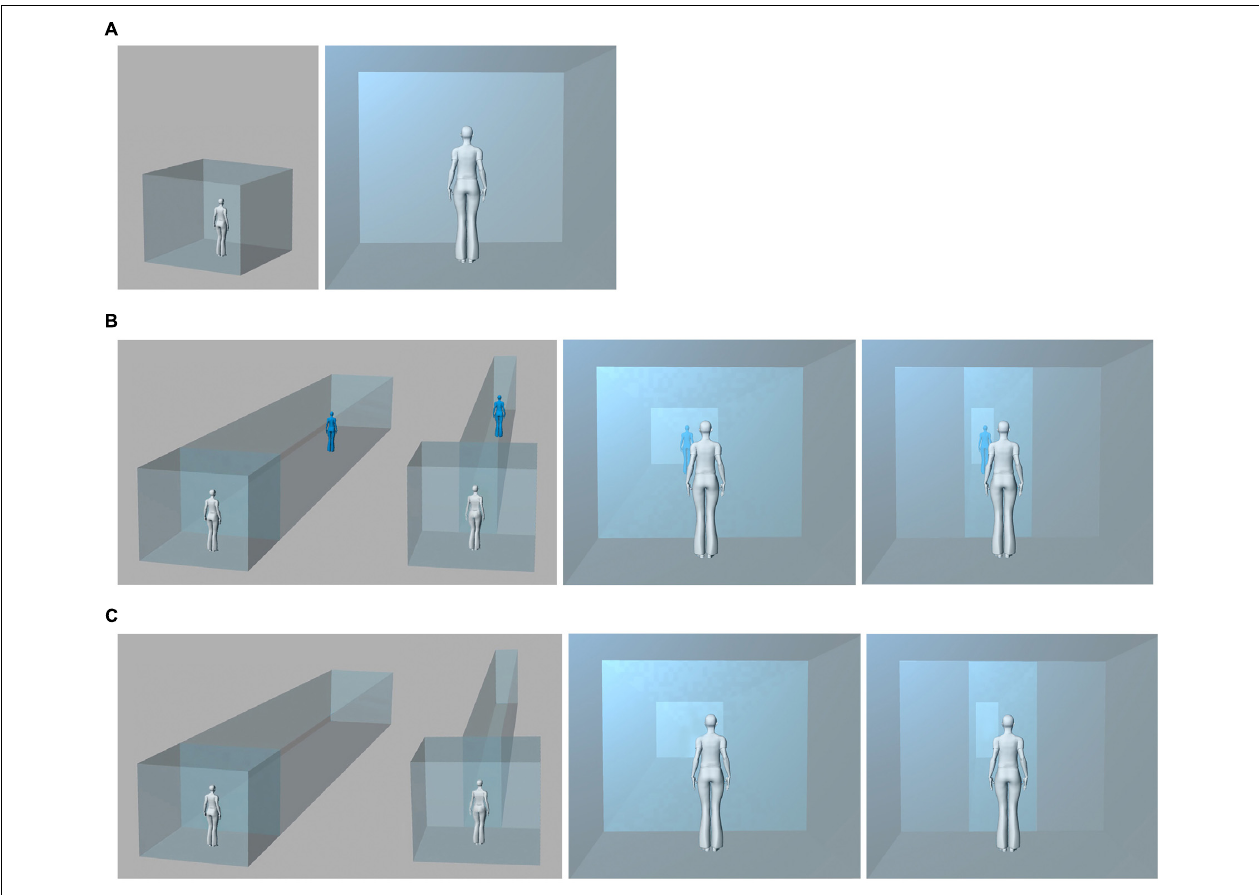
FIGURE 3 | The experimental setup. (A) The physical interior of the Virtual Reality arena: A Participant standing inside the Virtual Reality arena without virtual extension; her view in first person from behind the physical body oriented toward the rear-projection screen. (B) The physical interior and its virtual augmentation in Experiment 1: The participant stands inside the Virtual Reality arena with a large and narrow virtual interior extension; first person view of the augmented interior with an avatar (blue) and the physical body (white) from behind. (C) The physical interior and its virtual augmentation in Experiment 2: The participant stands inside the Virtual Reality arena with a large and narrow virtual interior; first person view of the augmented interior without the avatar and the physical body (white) from